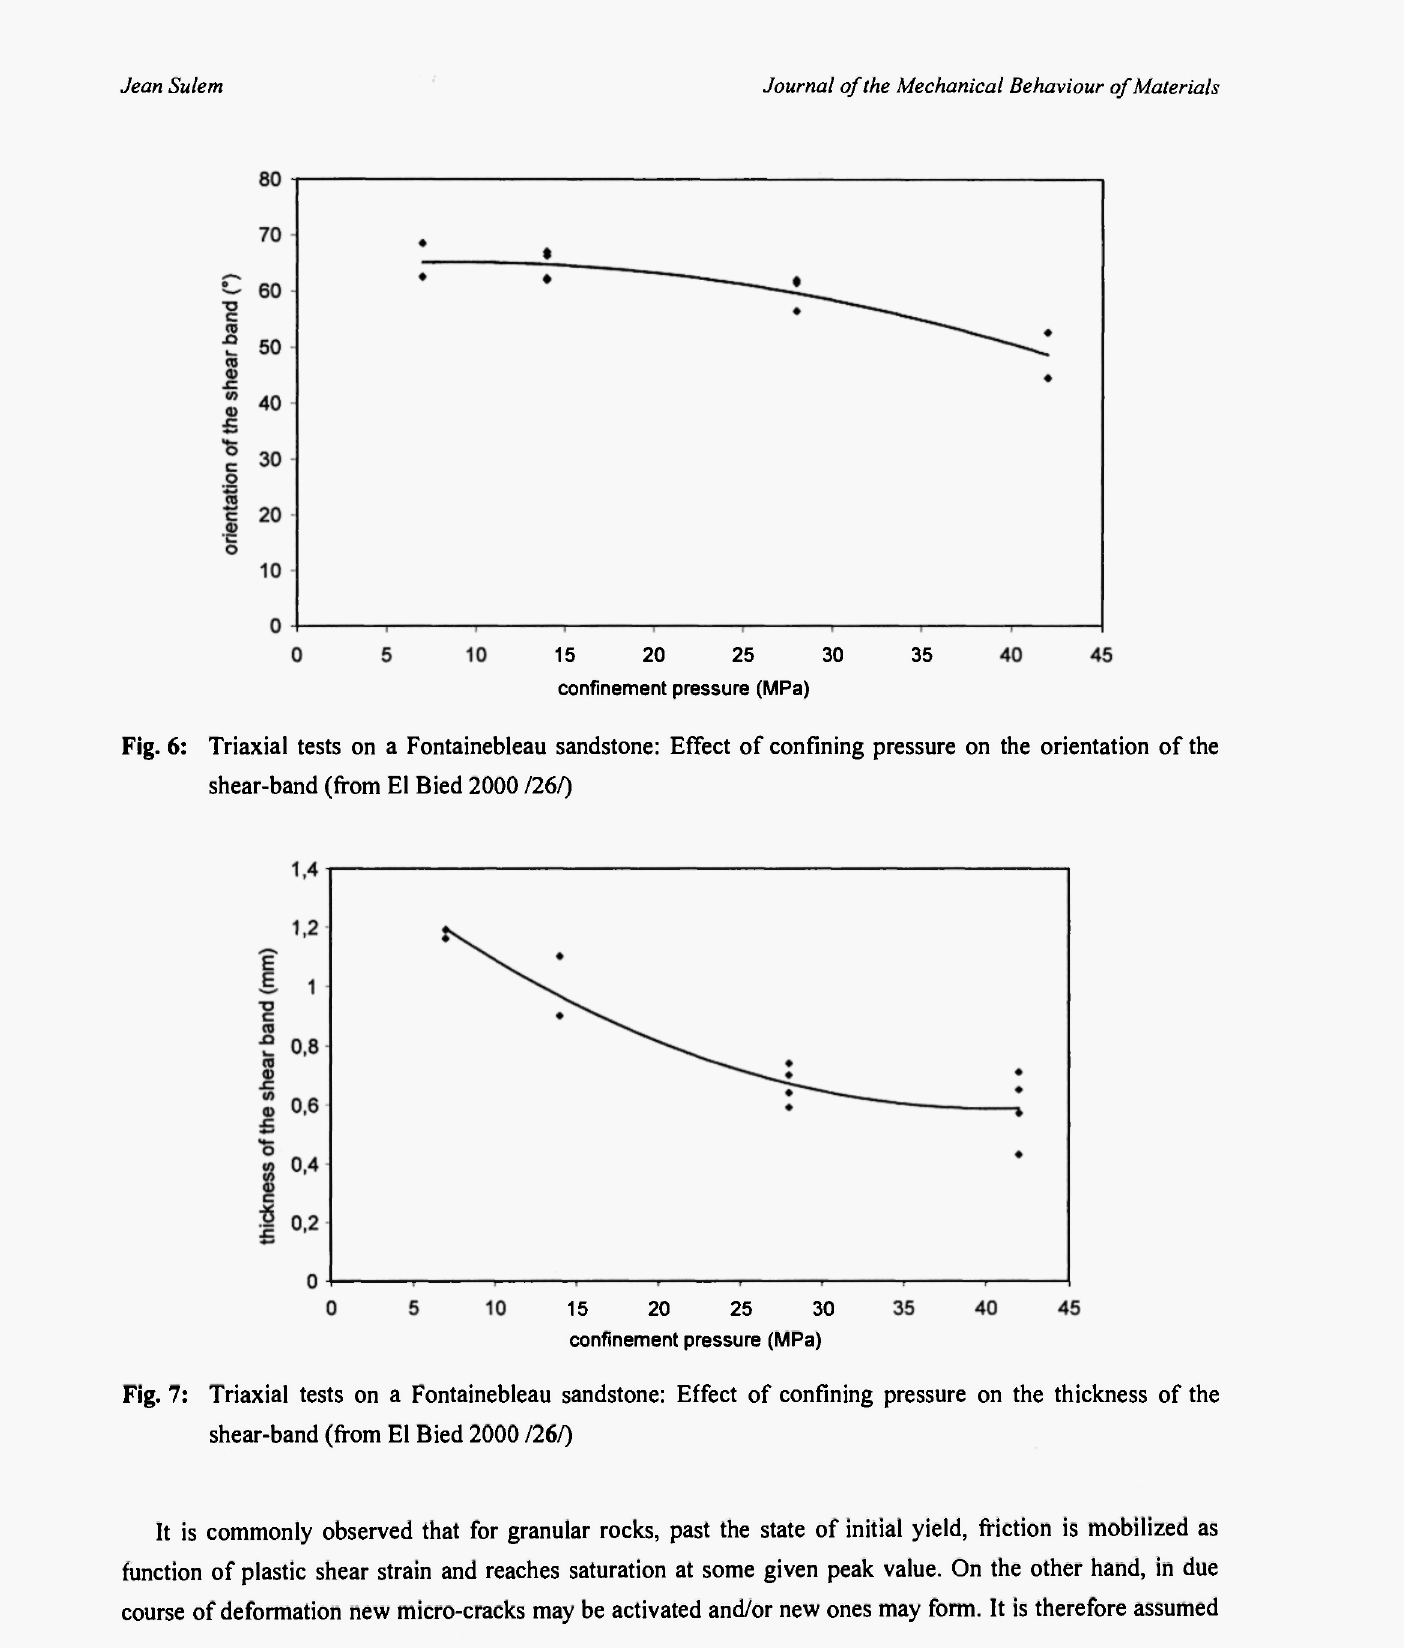
Fig. 7: Triaxial tests on a Fontainebleau sandstone: Effect of confining pressure on the thickness of the shear-band (from El Bied 2000